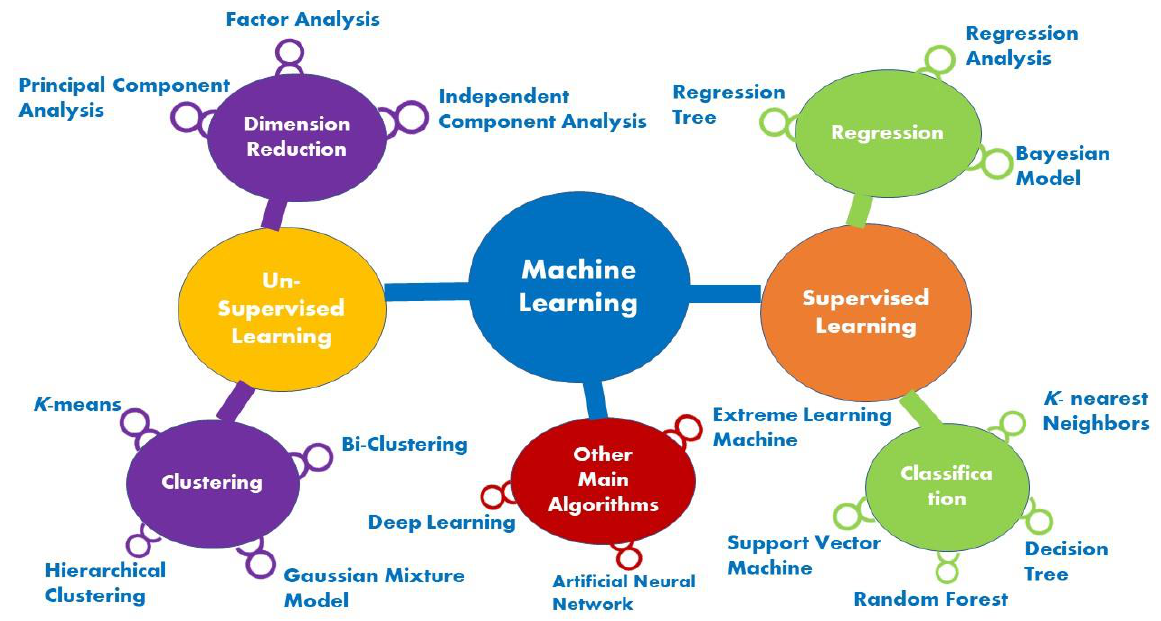
Figure 1. Machine Learning Algorithms.